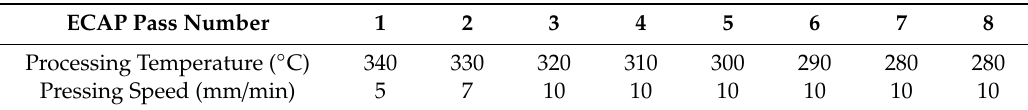
Table 1. ECAP (Equal-Channel Angular Pressing) procedure parameters of the investigated alloy. ECAP Pass Number